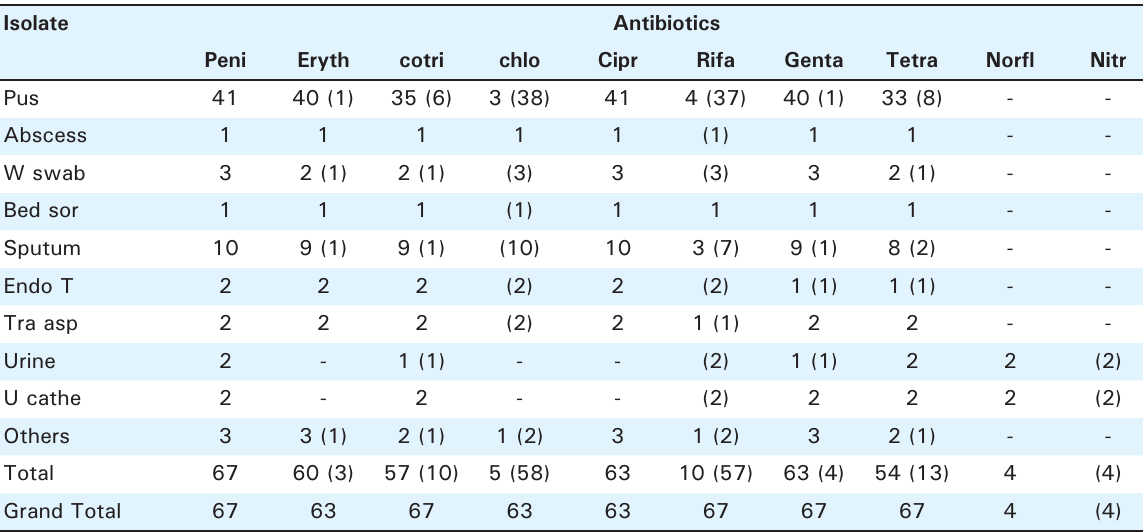
Table 2. Susceptibility pattern of MRSA Isolate